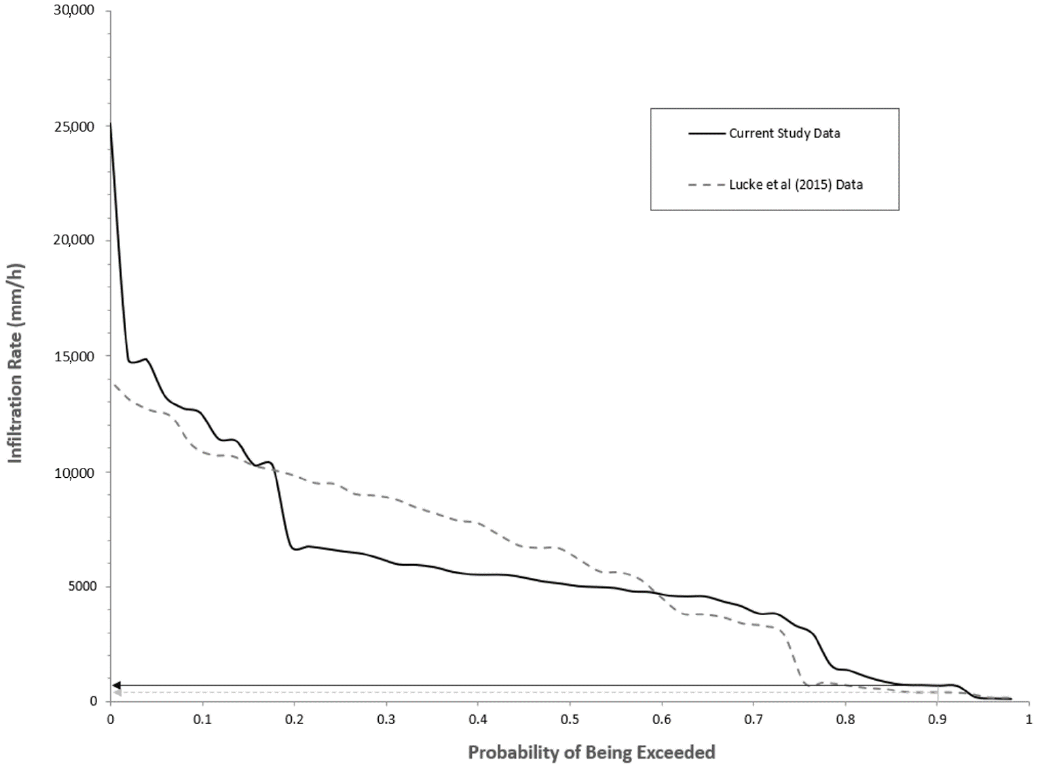
Figure 10. Probability of the infiltration rate being exceeded based on all data collected in this study and data from Lucke et al.